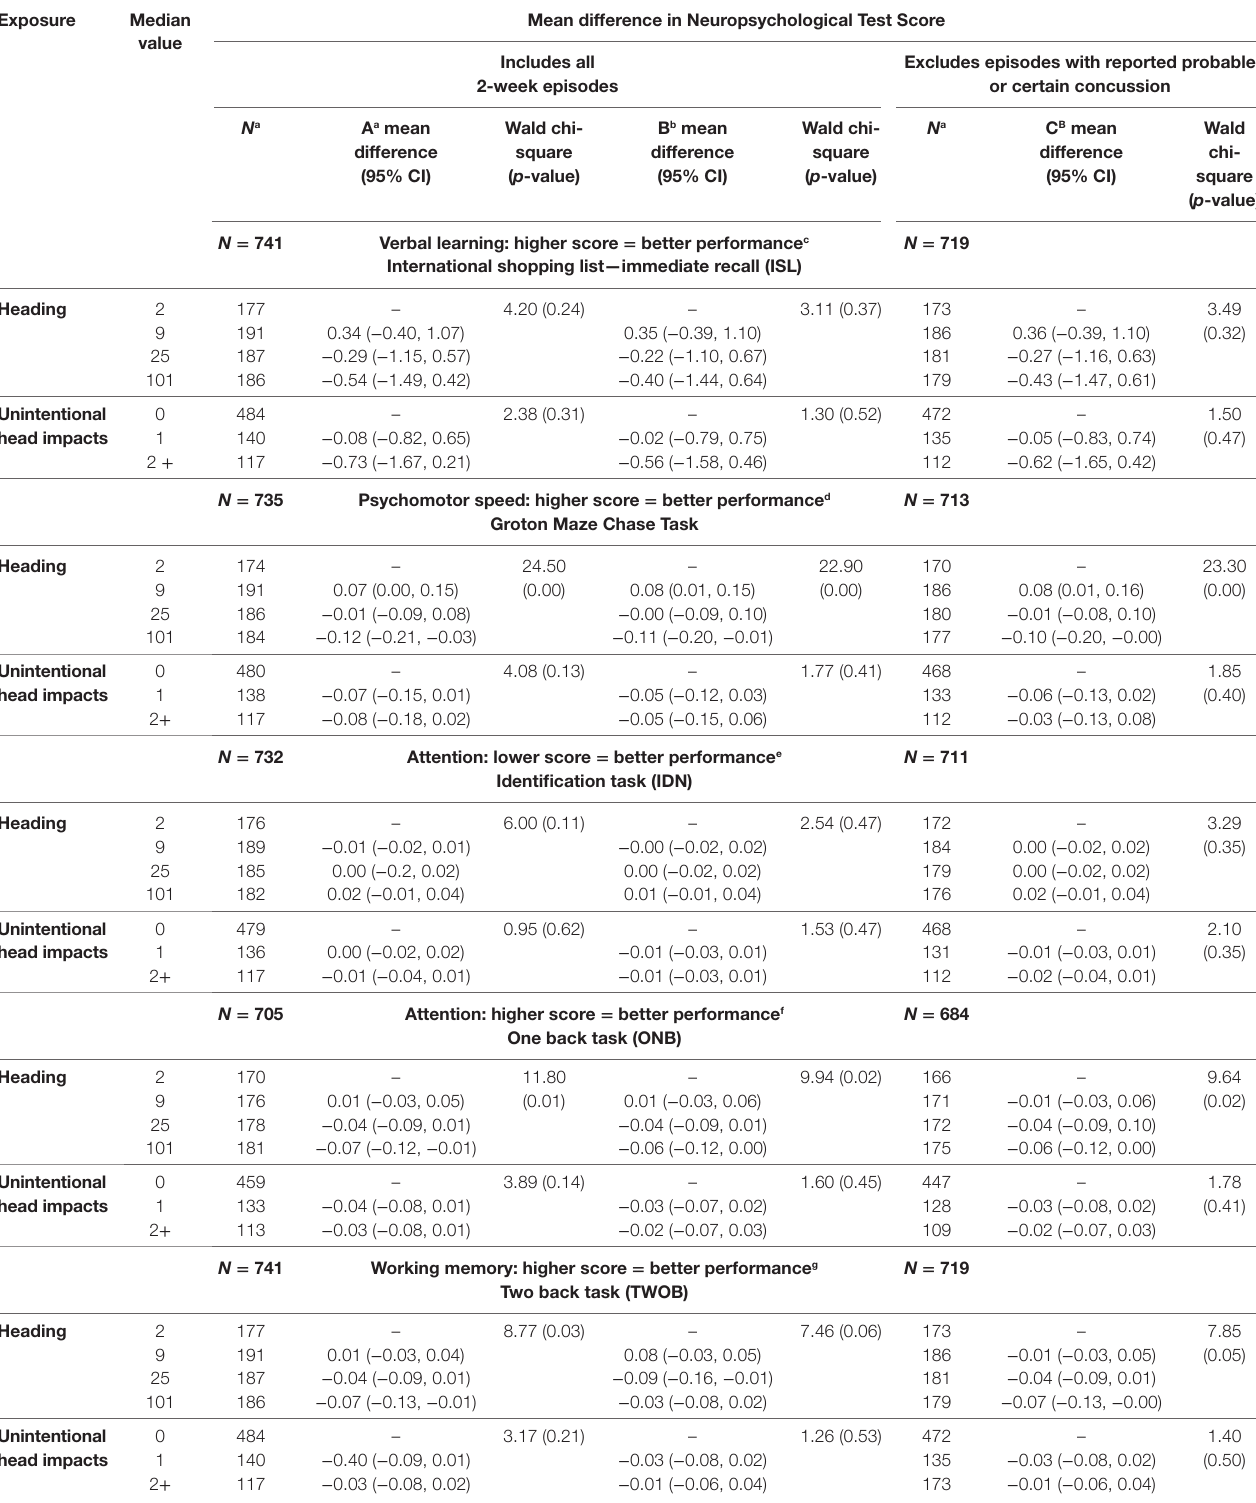
Table 3 | GEE model estimating the mean difference in NP test scores by heading exposure quartiles and by number of unintentional head impacts reported in a 2-week recall period.